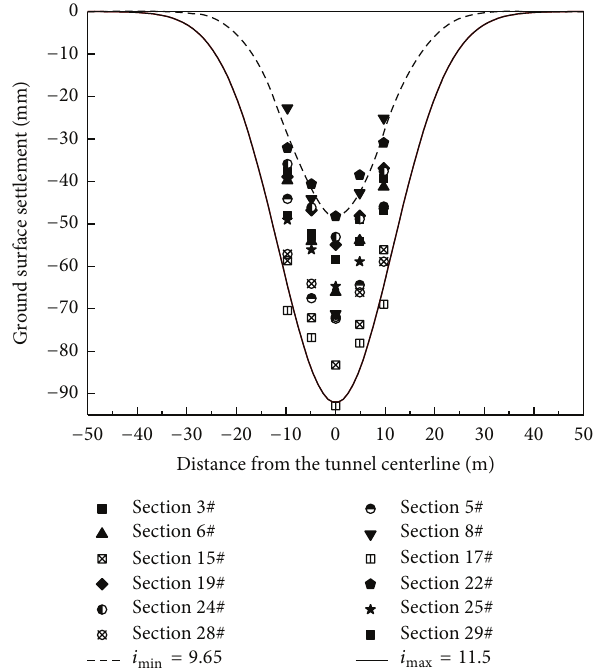
Figure 21: Fitting results of ground surface settlement